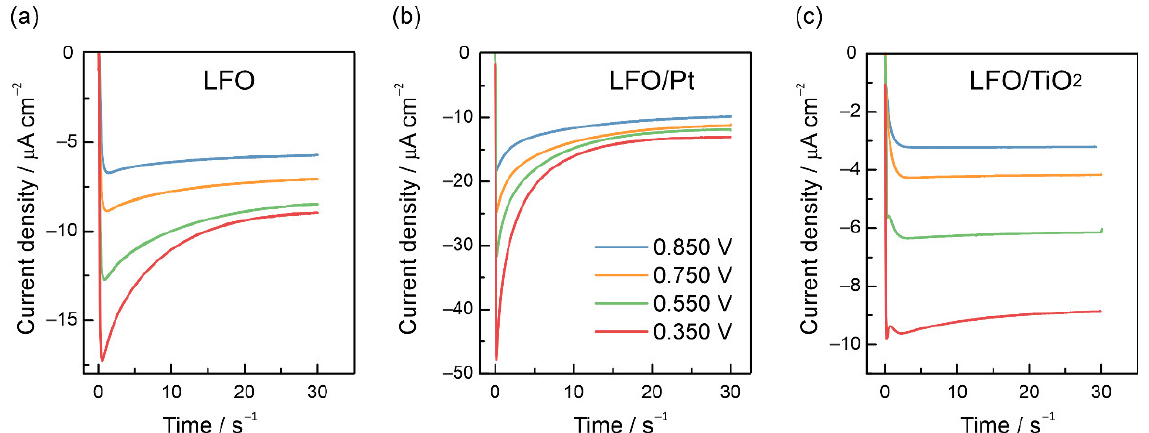
Figure 6. Potentiostatic photocurrent transients registered during the illumination periods for the LFO ( a ), LFO/Pt ( b ) and LFO/TiO 2 (1:100) ( c ) electrodes at potentials of 0.850, 0.750, 0.550, 0.350 V vs. RHE in deaerated 0.1 M NaOH solution.